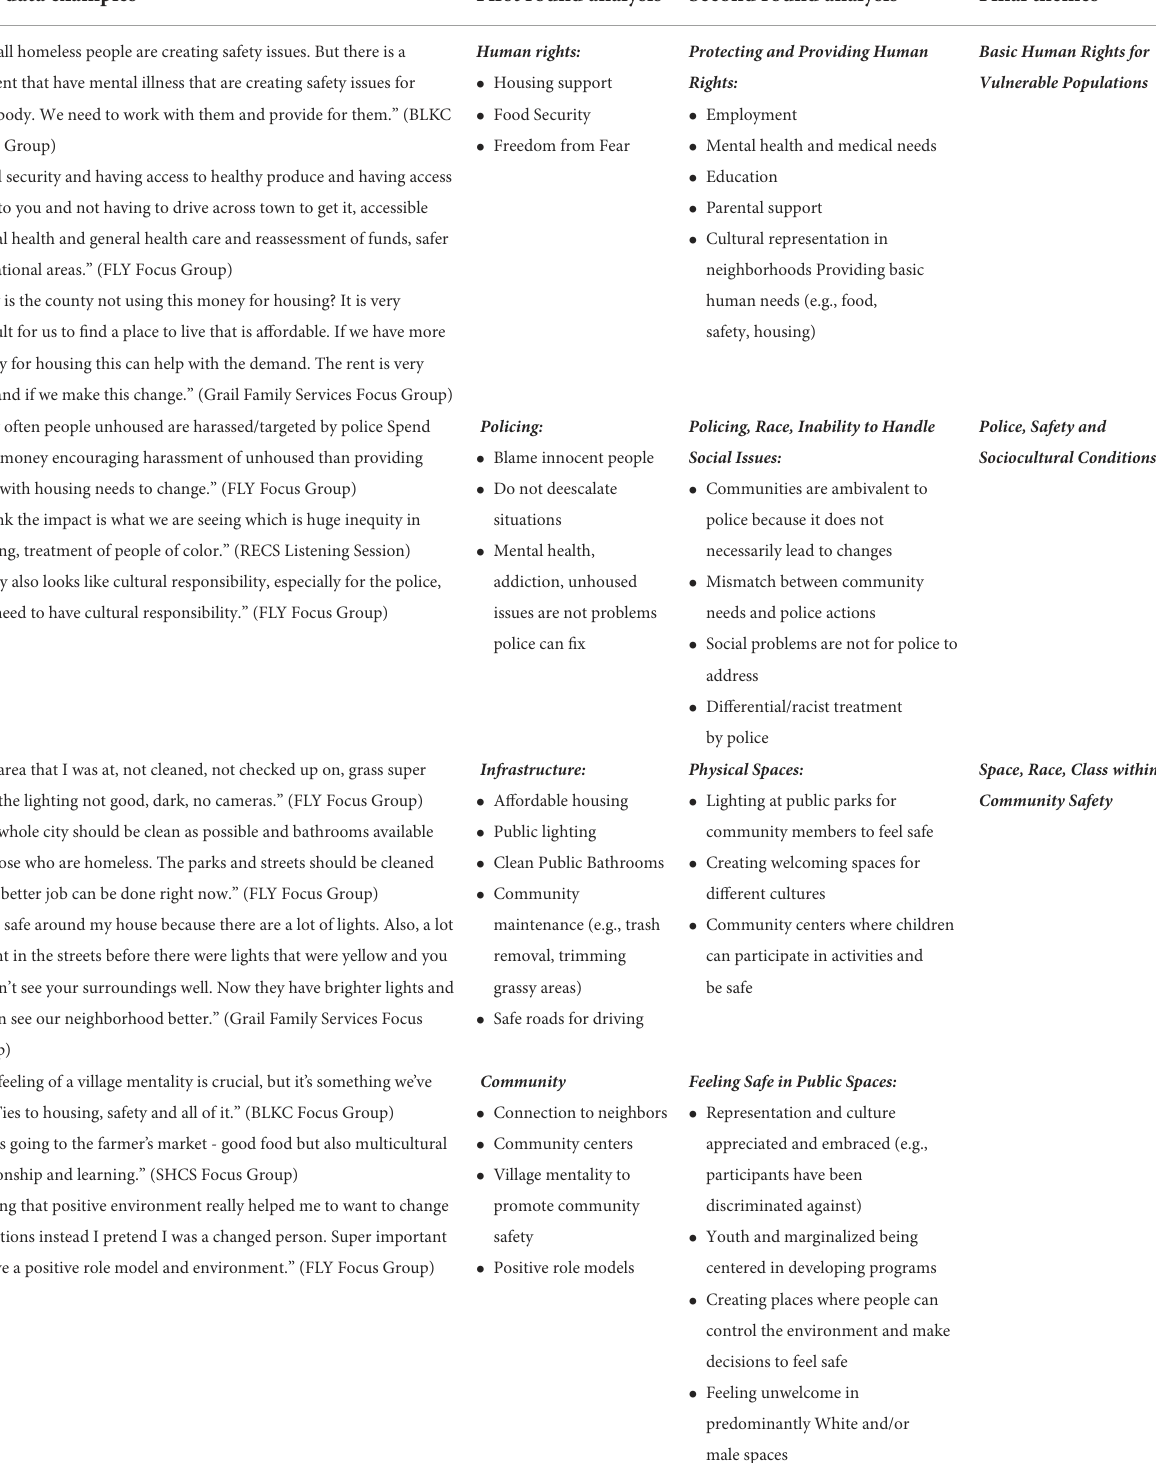
TABLE 2 Thematic qualitative data